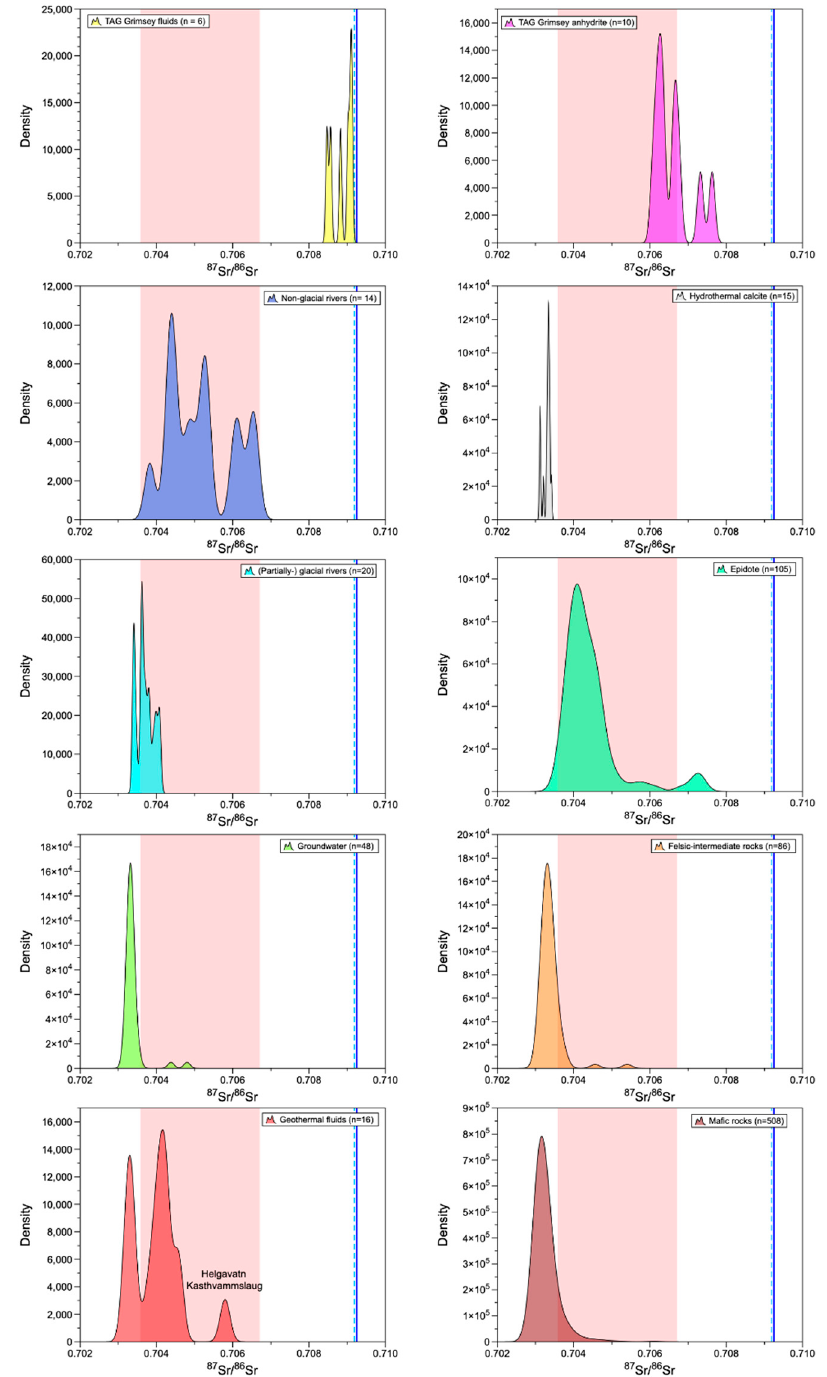
Figure 2. Probabilistic density histograms of the 87 Sr/ 86 Sr ratios in the fluids, minerals and rocks of Iceland. The red band indicates the range of 87 Sr/ 86 Sr values measured in the Theistareykir fluids. The blue line is the seawater value [45], while the dashed blue line is for glacier ice [52]. See Table S1 for the values. The bibliographic references for the geothermal fluids are [1,52]; groundwater are [53,54]; non-glacial, partially- and glacial rivers are [52,53]; TAG Grimsley fluids and anhydrite is [45]; hydrothermal calcite is [53]; epidote are [51,55]; and mafic, intermediate, and felsic igneous rocks are [49,51,56–73].